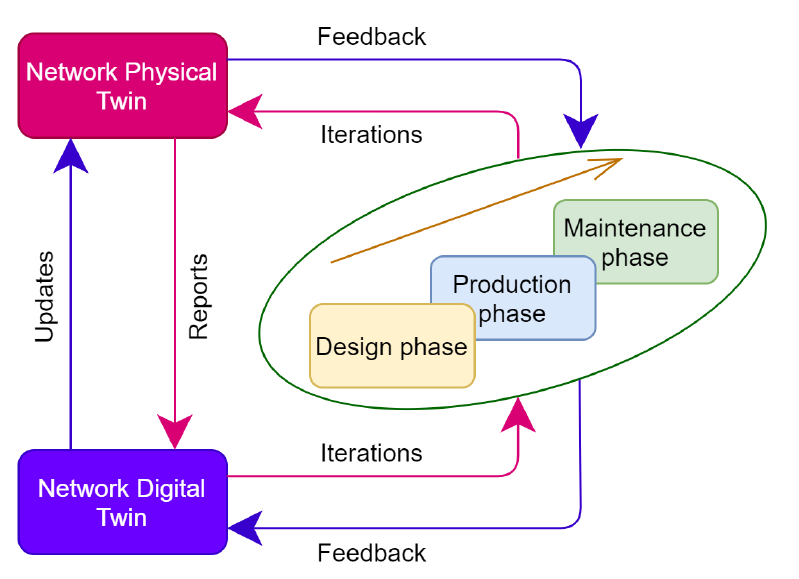
Figure 2. NDT role throughout the whole network development process.